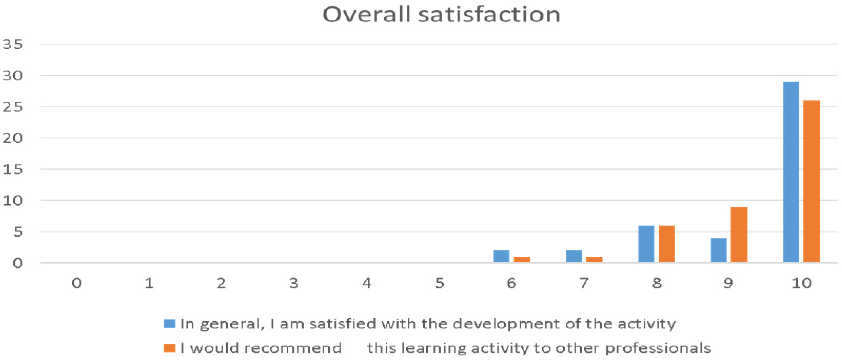
Figure 3. Overall satisfaction (CSD): x axe: strongly disagree or agree of satisfaction/y axe: number of responses.